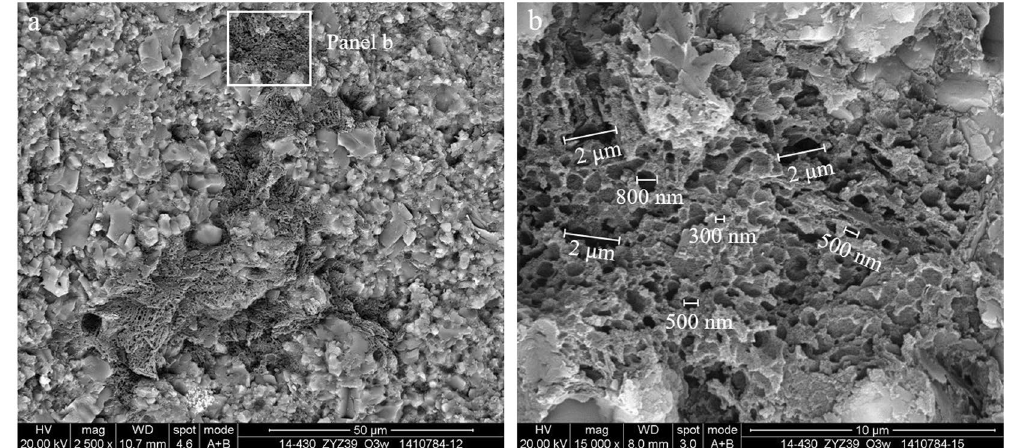
Figure 4. Multicellular algae of black shale in the Wufeng Formation in well Jiaoye 2 (2570.89 m). ( a ) Overview of the profile displaying rich multicellular algae. The aligned OM pores may be a result of the inherent variation in the internal structure of the algae. ( b ) Unaligned OM